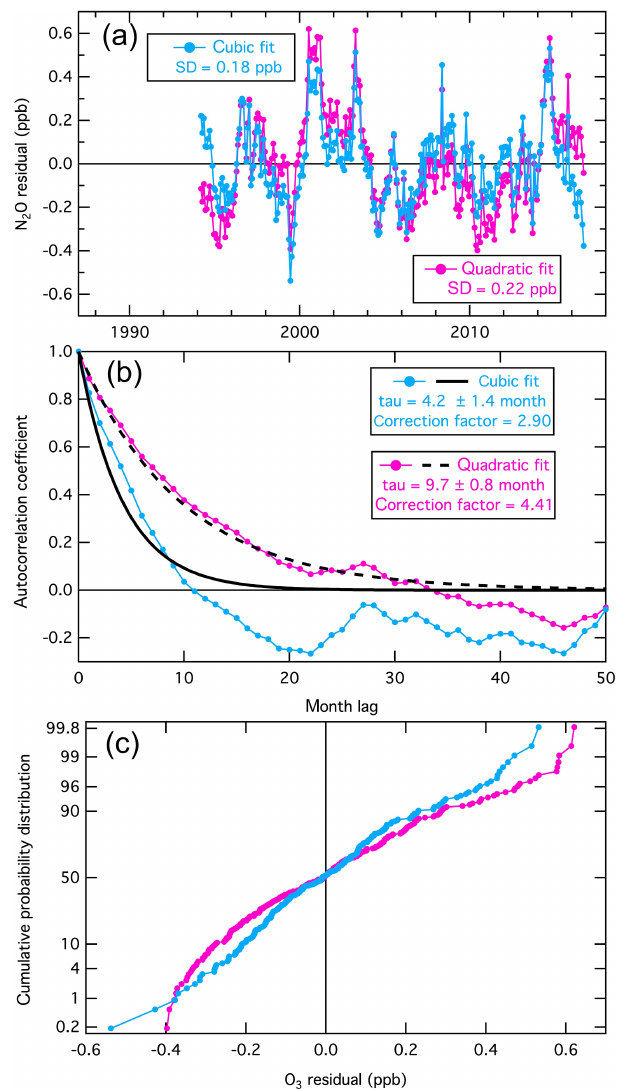
Figure 7. Analysis of the fit residuals for the monthly mean baseline N 2 O concentrations illustrated in Fig. 5d (blue points). For compar- ison, the violet results show the analysis with a quadratic fit to the long-term changes. The annotations are similarly color coded. The format of the figure is generally the same as that of Fig.